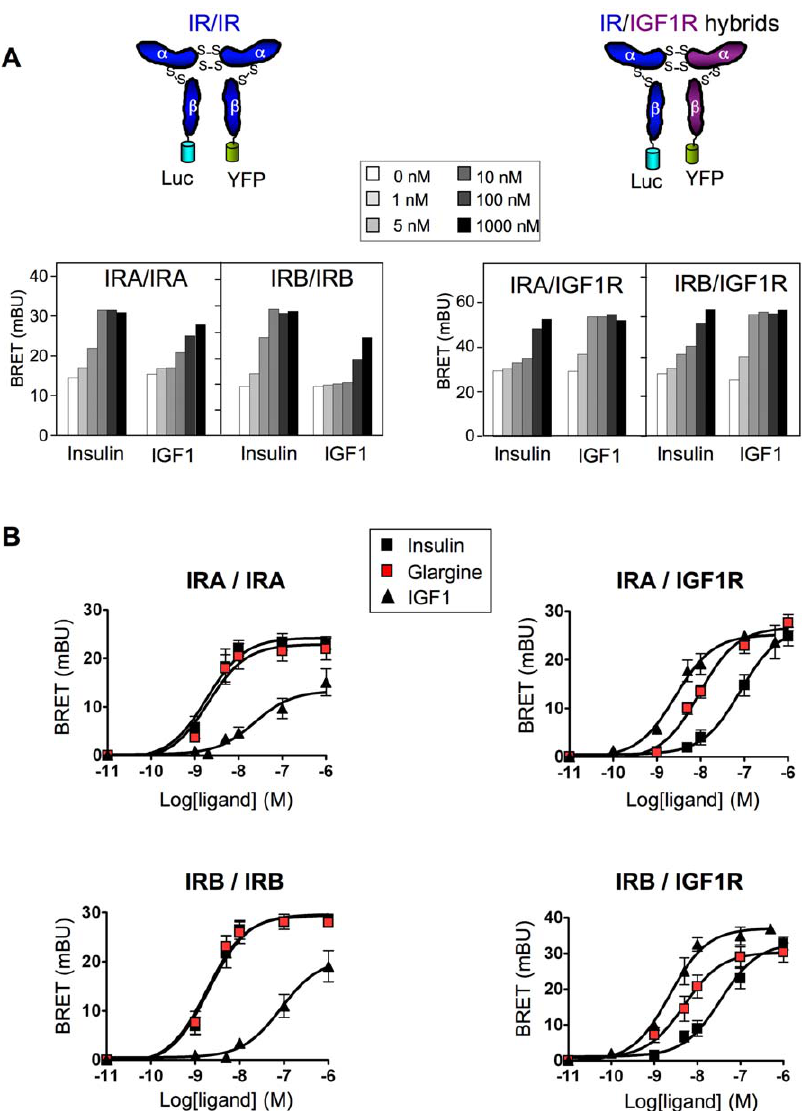
Figure 1. Effect of insulin, glargine and IGF1 on IR homodimers and IR/IGF1R hybrid receptors. HEK-293 cells were co-transfected with IRA-Luc/IRA-YFP, IRB-Luc/IRB-YFP, IRA-Luc/IGF1R-YFP or IRB-Luc/IGF1R-YFP. Receptors were partially purified by WGL chromatography. Ligand binding induces a conformational change that brings the two ß-subunits in close proximity, resulting in an energy transfer between the luciferase and YFP. BRET assays were performed in the presence of increasing ligand concentrations. (A) Typical experiments showing basal and insulin or IGF1 stimulated BRET signals. (B) Dose-response curves showing the effect of insulin, IGF1 and glargine on IR homodimers and IR/ IGF1R hybrids. Ligand-induced BRET (BRET above basal) was determined at each ligand concentration and was used to establish dose-response curves. Results are the means 6 S.E.M. of 4 to 6 independent experiments. EC50 for insulin, IGF1, glargine and other insulin analogues are given in Table